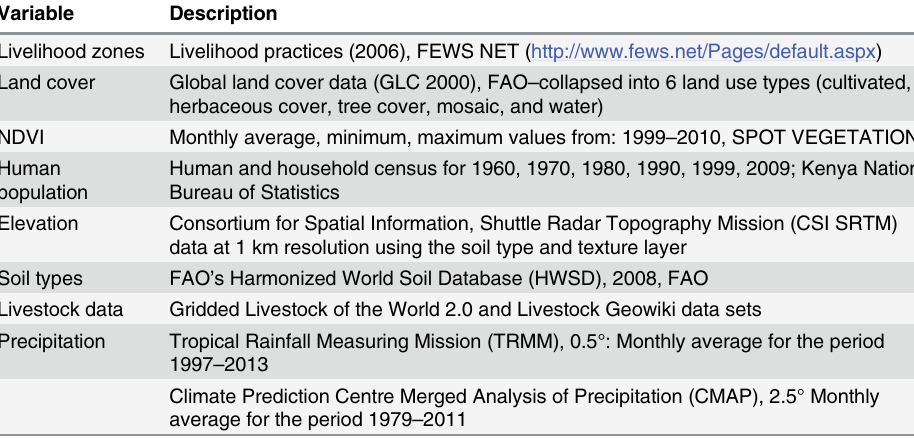
Table 1. List of putative risk factors tested for their relationship with Rift Valley Fever